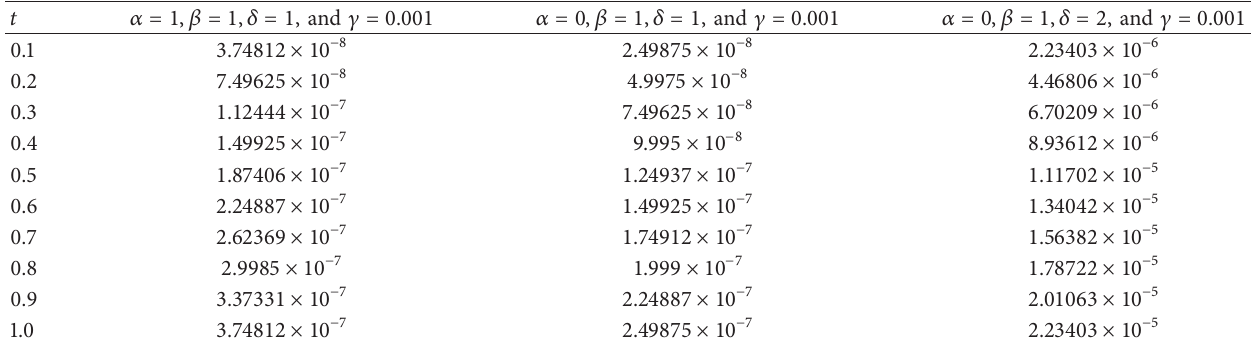
Table 4: Absolute errors of OHAM for 𝛼 = 0, 1 , 𝛽 = 1 , 𝛿 = 1, 2 , and 𝑥 = 2 .